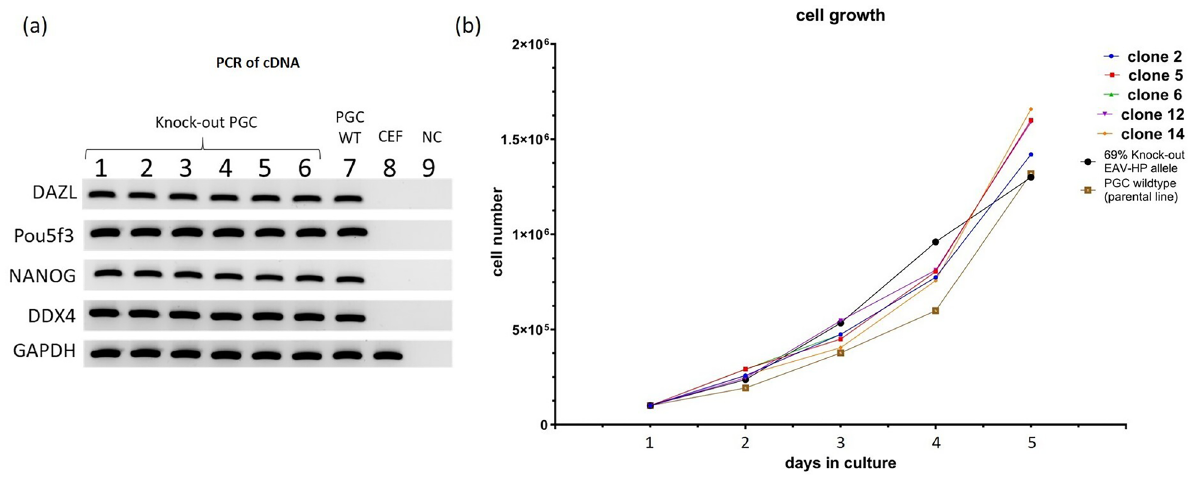
Figure 6. Committed stem cell character and growth curves of PGCs. ( a ) Marker gene expression of knock-out clones (1–6), wildtype PGCs (7) and chicken embryo fibroblasts (CEF) (8), 9: blank—no cDNA control (NC), pluripotency marker (PCR of cDNA): NANOG, Pou5f3 , stem cell marker: DAZL, DDX4 , housekeeping gene: GAPDH, 1–5: 5 representative knock-out cell clones (no. 2, 5, 6, 12 and 14, see Fig. S4), 6: knock-out clone (mixed cell population with 69% EAV-HP knock-out alleles (see Table 1), ( b ) PGC growth curves of wildtype and knock-out PGCs. The cell count was initially set at 100.000 cells and the cell count was determined over 5 days using a hemocytometer. The doubling time ranged from 30 to 32 h (Table S5). For uncropped versions of ( a ) see Fig.